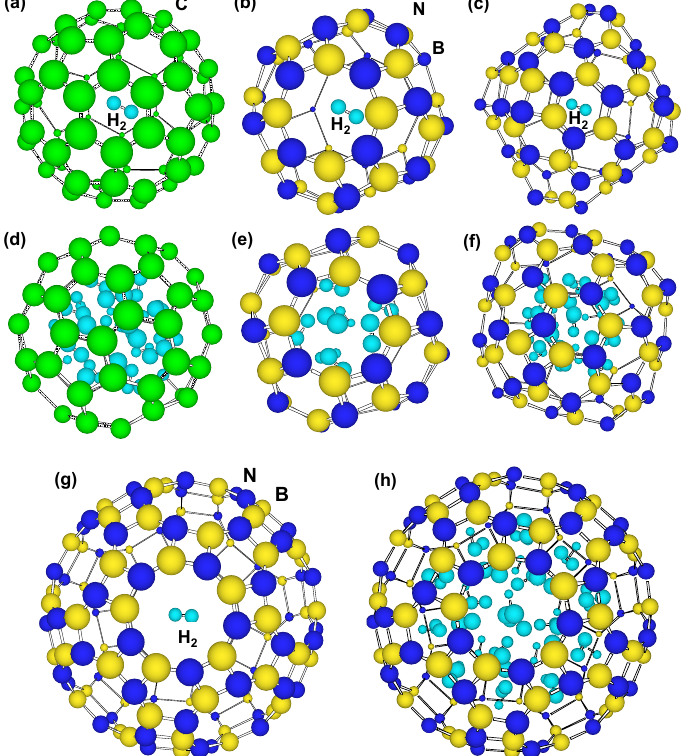
Figure 7. Optimized structural models of H 2 molecules in the clusters. A H 2 molecule in the center of ( a ) C 60 ; ( b ) B 24 N 24 ; ( c ) B 36 N 36 ; ( d ) 22 H 2 molecules inside C 60 and 8 atoms chemisorbed; ( e ) 9 H 2 molecules in B 24 N 24 ; and ( f ) 20 molecules in B 36 N 36 ; ( g ) 1 and ( h ) 38 H 2 molecules in B 60 N 60